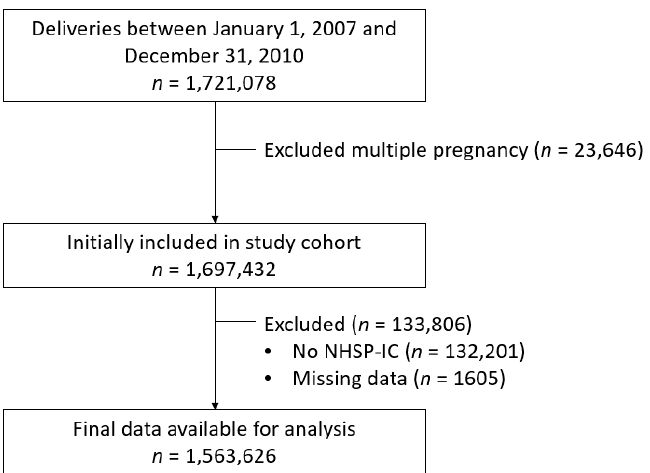
Figure 1. Flowchart of participant enrollment. NHSP-IC, National Health Screening Program for Infants and Children.